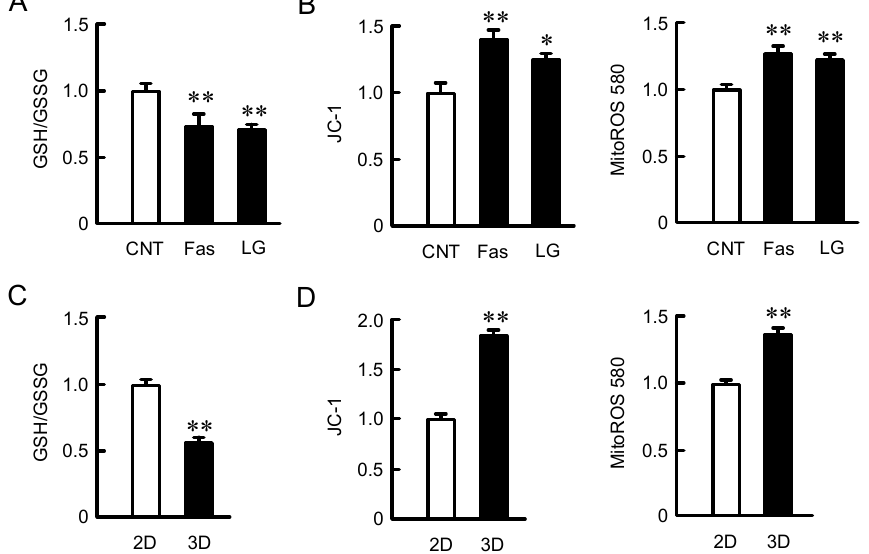
Figure 6. Effects of fasentin, low glucose and 3D culture on glutathione redox state and mitochondria activity. ( A , B ) A549 cells cultured on 96-well flat plates were incubated in the absence (CNT) and presence of 10 µ M fasentin (Fas) or 5 mM glucose (LG) for 6 h. ( C , D ) A549 cells were cultured on 96-well flat plates (2D) or round-bottomed plates (3D). The glutathione redox state was measured by a GSSG/GSH Quantification Kit. The mitochondrial potential was examined using JC-1, and the ratios of red and green fluorescence were calculated by ImageJ. The mitochondrial ROS production was examined using MitoROS 580. The values in 3D, fasentin-treated, or LG-treated cells are represented relative to the values in CNT or 2D. n = 6–8. ** p < 0.01 and * p < 0.05 compared with CNT or 2D.